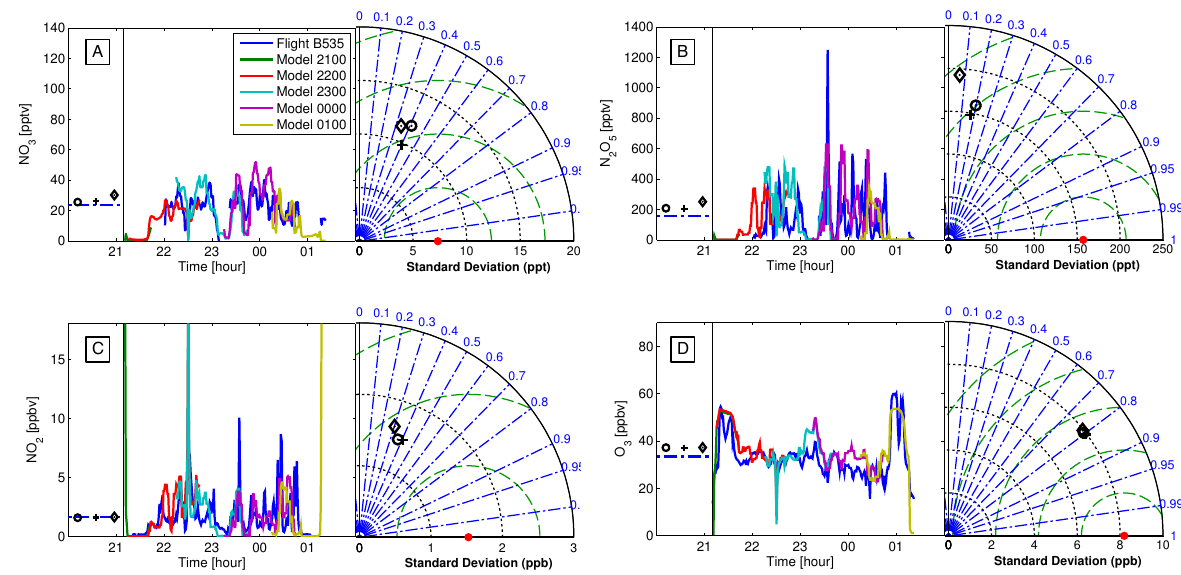
Figure 7. Flight track measurement–model comparisons for key nitrate species for flight B535. Main plots show 1min averaged measure- ments (blue lines) and data from the “het on” model scenario (multi-coloured lines) for NO 3 , N 2 O 5 , NO 2 , and O 3 ( a–d , respectively). The side panels on the left of each plot show the mean values for each diagnostic species along the flight track, while the Taylor diagrams on the right show the standard deviations of, and correlations between, the individual model scenarios and measurements. In these side plots the measurement data are represented by the red dot and blue dash-dotted line, while the “het on”, “no Cl pathway”, and “het off” model scenarios are represented by the black circle, black cross, and black diamond, respectively. Table 3. Model